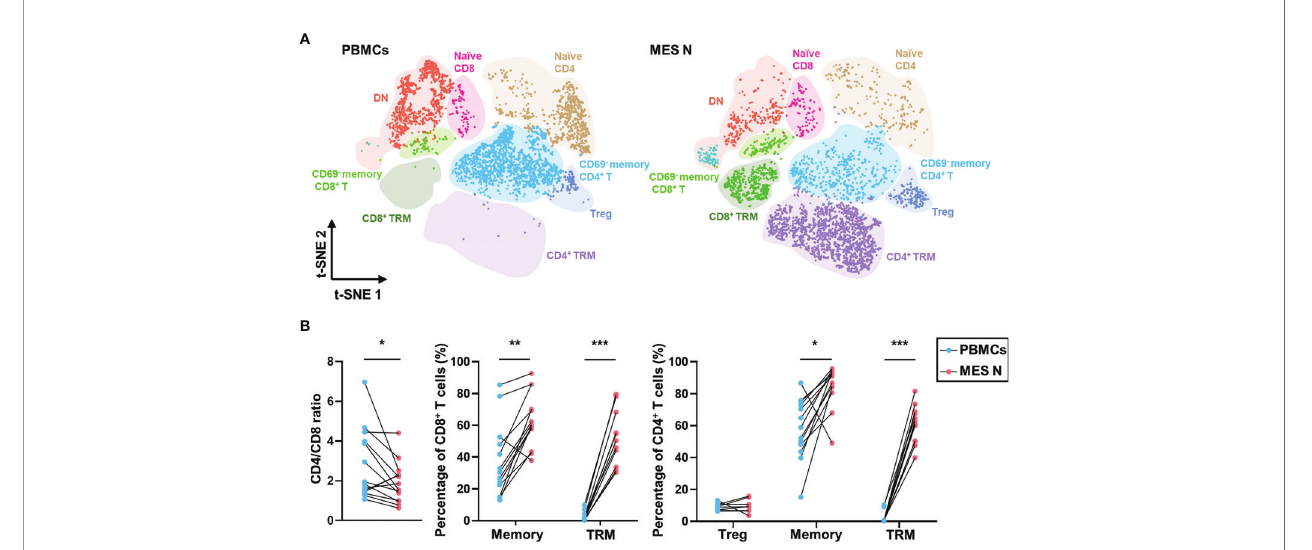
FIGURE 2 | T-SNE plot and percentages of T cells in the PBMCs and MES N. (A) T-SNE plot of T cells in the PBMCs and MES N with main subclusters indicated. (B) CD4/CD8 ratio, percentages of memory CD8 + T cells, CD8 + TRM cells, Treg cells, memory CD4 + T cells, and CD4 + TRM cells in the PBMCs and MES N. (*p < 0.05; **p < 0.01; ***p <